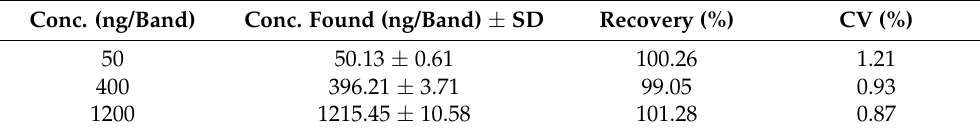
Table 3. Determination of the accuracy of AA for the greener HPTLC method a .